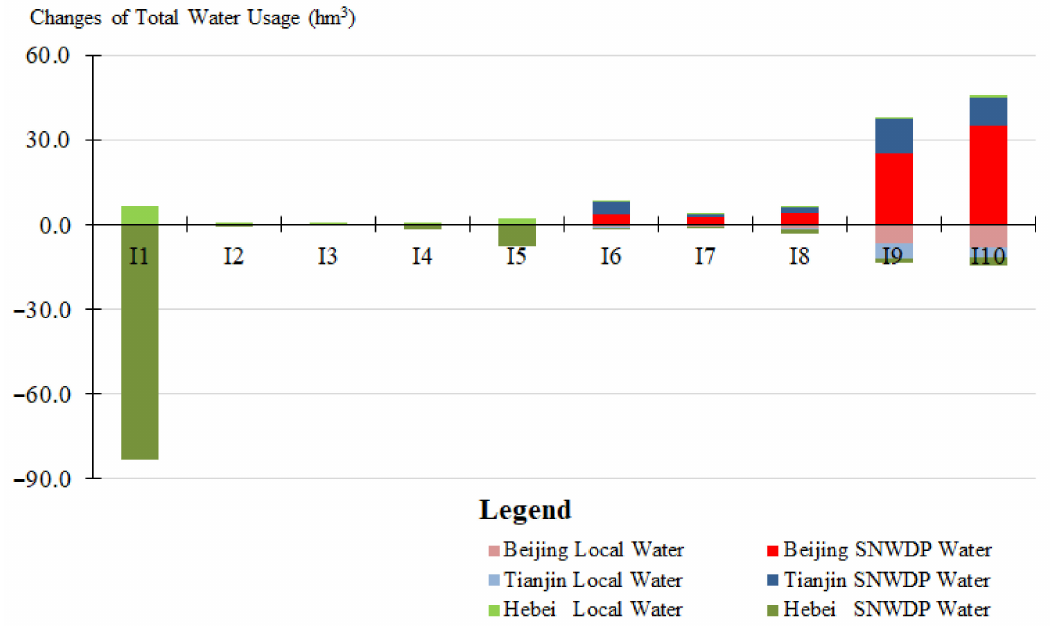
Figure 4. Changes in total water usage in T1P1 relative to T1P0 (I1: agriculture; I2: general light industry; I3: general heavy industry; I4: water intensive light industry; I5: water intensive heavy industry; I6: construction; I7: trade; I8: transport; I9: general service; I10: water intensive